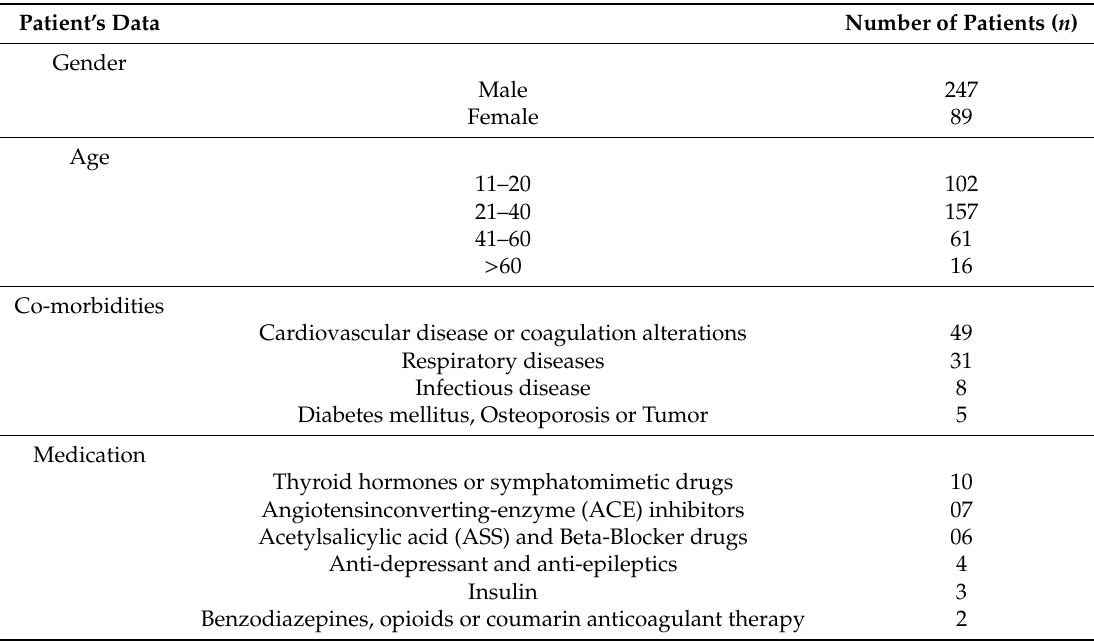
Table 1. Patient´s